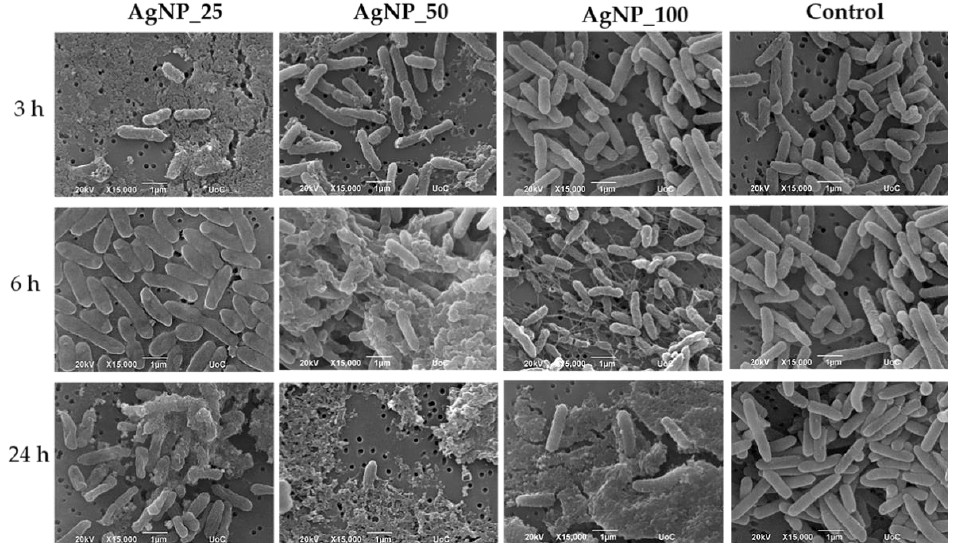
Figure 3. Representative SEM images showing the induction of 100 ppm AgNPs on P. aeruginosa for 3, 6 and 24 h. The control represents the morphology of the bacteria without AgNPs. Magnification is 15,000× and scale bar represents 1 μ m.